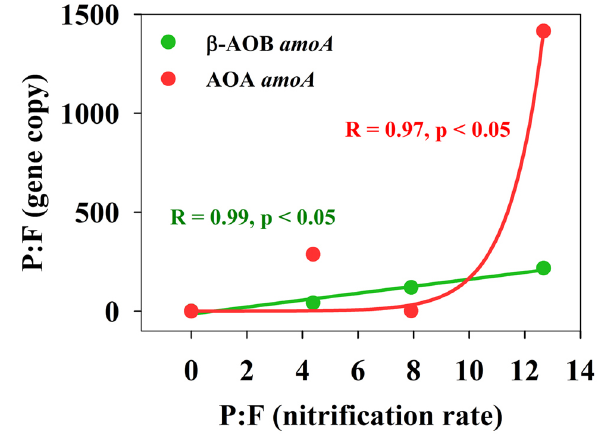
Fig. 8. β -AOB and AOA amoA and nirS gene abundances from the particle-associated ( > 3µm) and free-living (0.2 ∼ 3µm) communi- ties in the salinity and latitude transects. Error bars indicate standard deviation. Asterisks indicate statistically significant differences be- tween the particle-associated and free-living samples. (a) and (b) represent the surface and bottom samples of sites Y0, Y3 and Y5 along the salinity transect. (c) and (d) represent the surface and bot- tom samples of sites YE5, YE4, YE3, YE2, YE1 and YE0 along the latitude transect. B: below detection limit; N: not detected due to lack of enough environmental DNA.